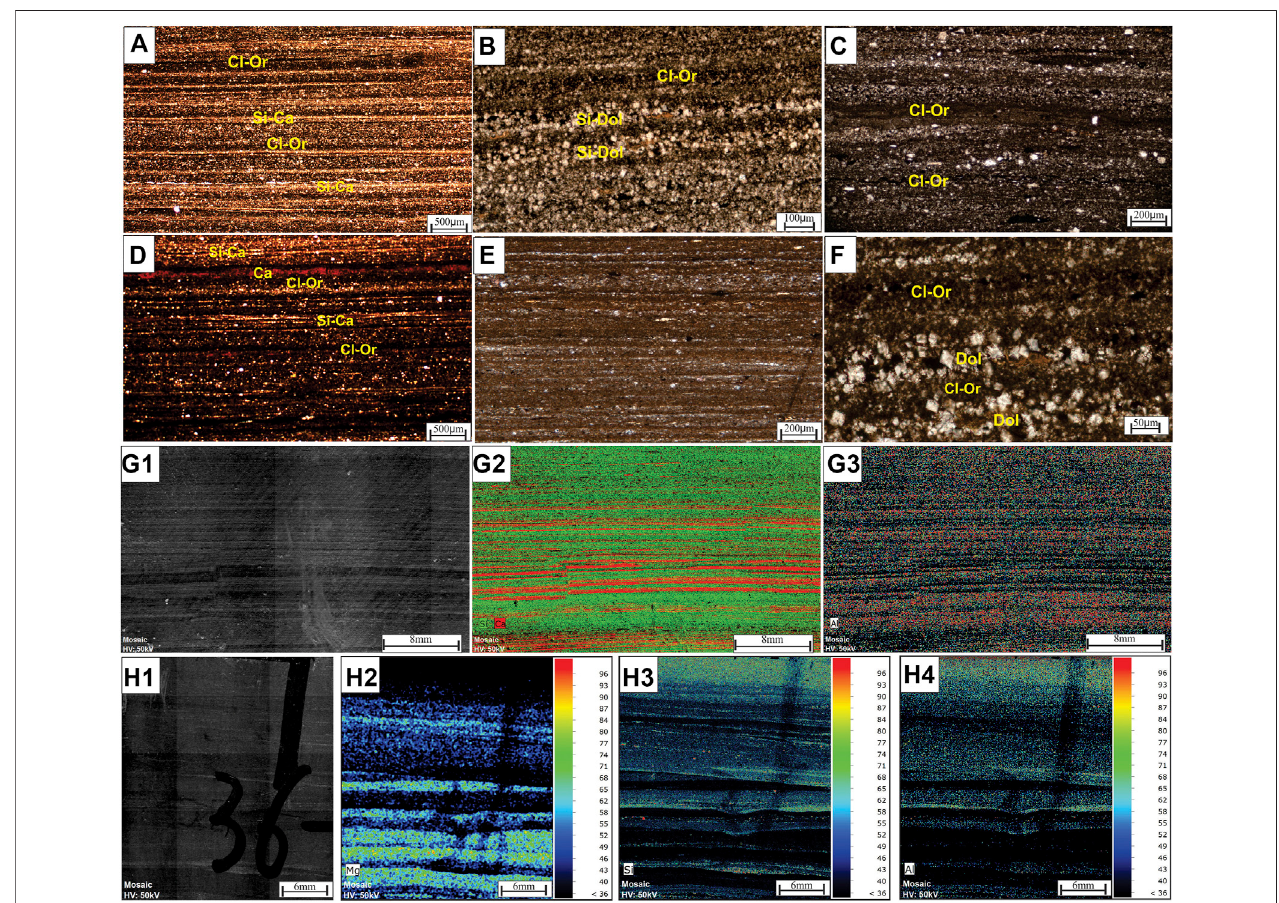
FIGURE 3 | Various laminated types developed in the mixed sedimentary rocks [ (A – F) : single polarized light; (G,H) : XRF scan].